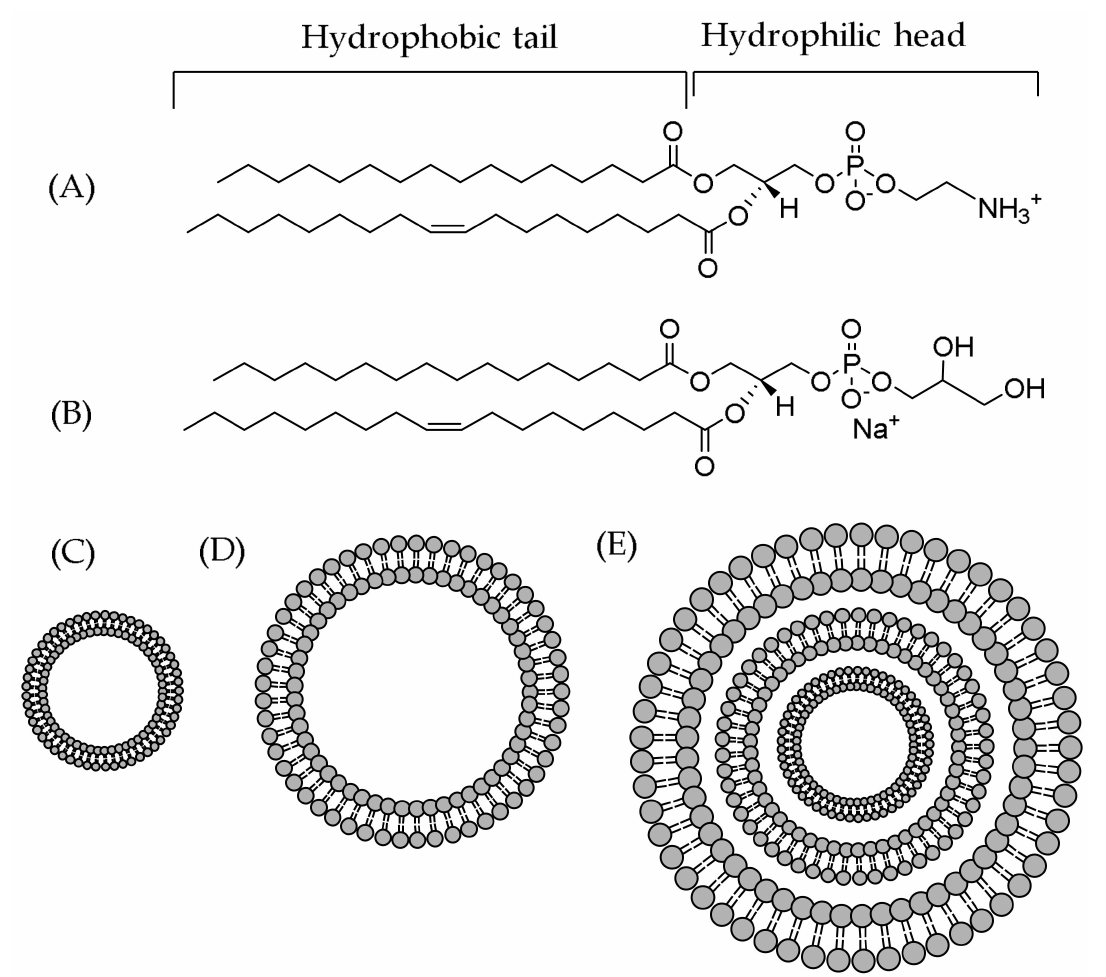
Figure 2. Examples of the model phospholipids used for the biophysical and interaction experi- ments: ( A ) 1-palmitoyl-2-oleoyl-sn-glycero-3-phosphocholine (POPC) and ( B ) 1-palmitoyl-2-oleoyl- sn-glycero-3-phosphatidylglycerol (POPG), and the classification of liposomes based on their lamel- larity: ( C ) small unilamellar vesicle (around 20–100 nm) and ( D ) large unilamellar vesicle (around 100–250 nm) consisting of a single phospholipid bilayer, and ( E ) multilamellar vesicle (around 1–5 µ m) consisting of many phospholipid bilayers. The vesicles are not on the same scale but